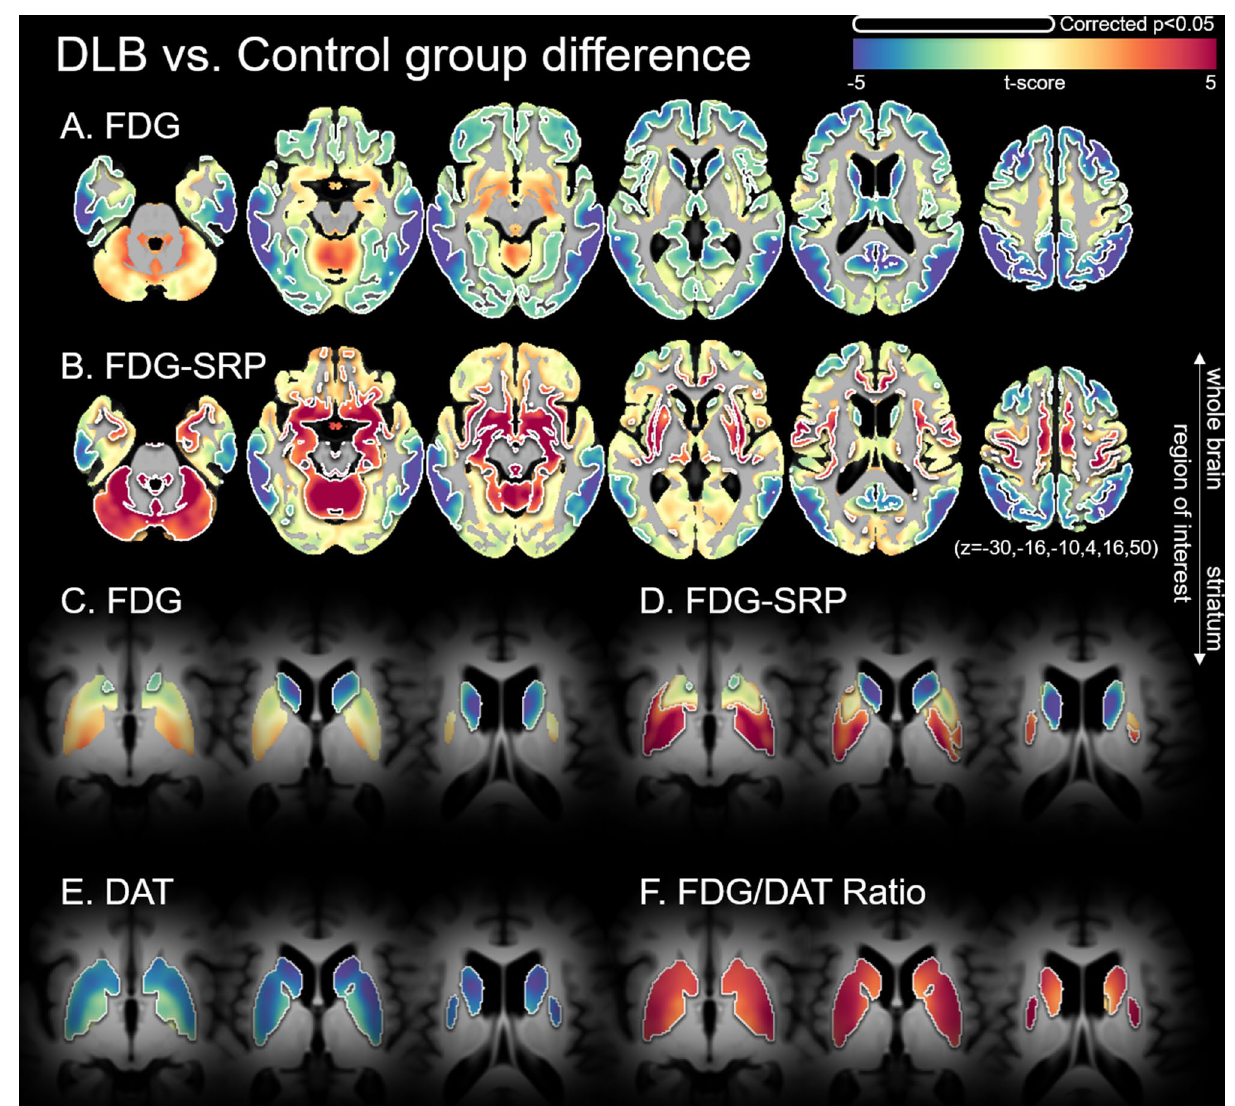
Figure 2. Comparison of FDG, DAT, and the FDG/DAT ratio between DLB and control groups. ( A , C , E , F ) are based on a general linear model for the voxel-wise standardized uptake value ratio using cerebellar crus-II as a reference region, and ( B , D ) are based on the general linear model for voxel-wise FDG subject residual profile. FDG/DAT ratio represents the voxel-wise proportion of FDG and DAT uptake. Age, sex, education, HTN, DM, DWMH, and PWMH are controlled for in the statistical model. The color scale indicates t values in the statistical analysis; red color indicates a higher metabolism in the DLB group compared to the control group, and blue color shows the inverse. Areas bounded by a white line indicate brain regions where the group difference is significant after correcting for multiple comparisons (corrected p < 0.05, false discovery ratio). Axial planes are displayed on Montreal Neurological Institute stereotaxic space in neurological convention ( A , B : z = − 30, − 16, − 10, 4, 16, 50; C , F : z = − 5, 5, 15). DAT dopamine transporter, DLB dementia with Lewy- bodies, DM diabetes mellitus, DWMH deep white matter hyperintensities, FDG 18 F-Fluorodeoxyglucose, HTN hypertension, PWMH periventricular